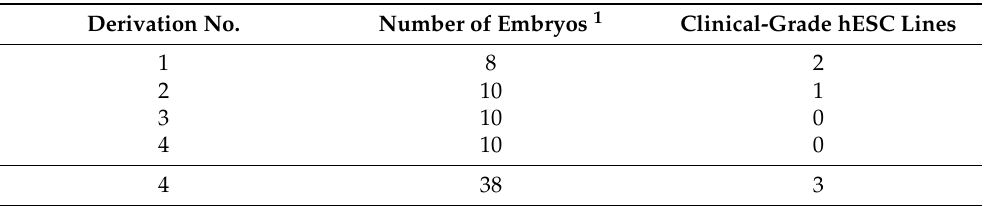
Table 1. Overview of the derivations of the clinical-grade hESC lines. Derivation No.